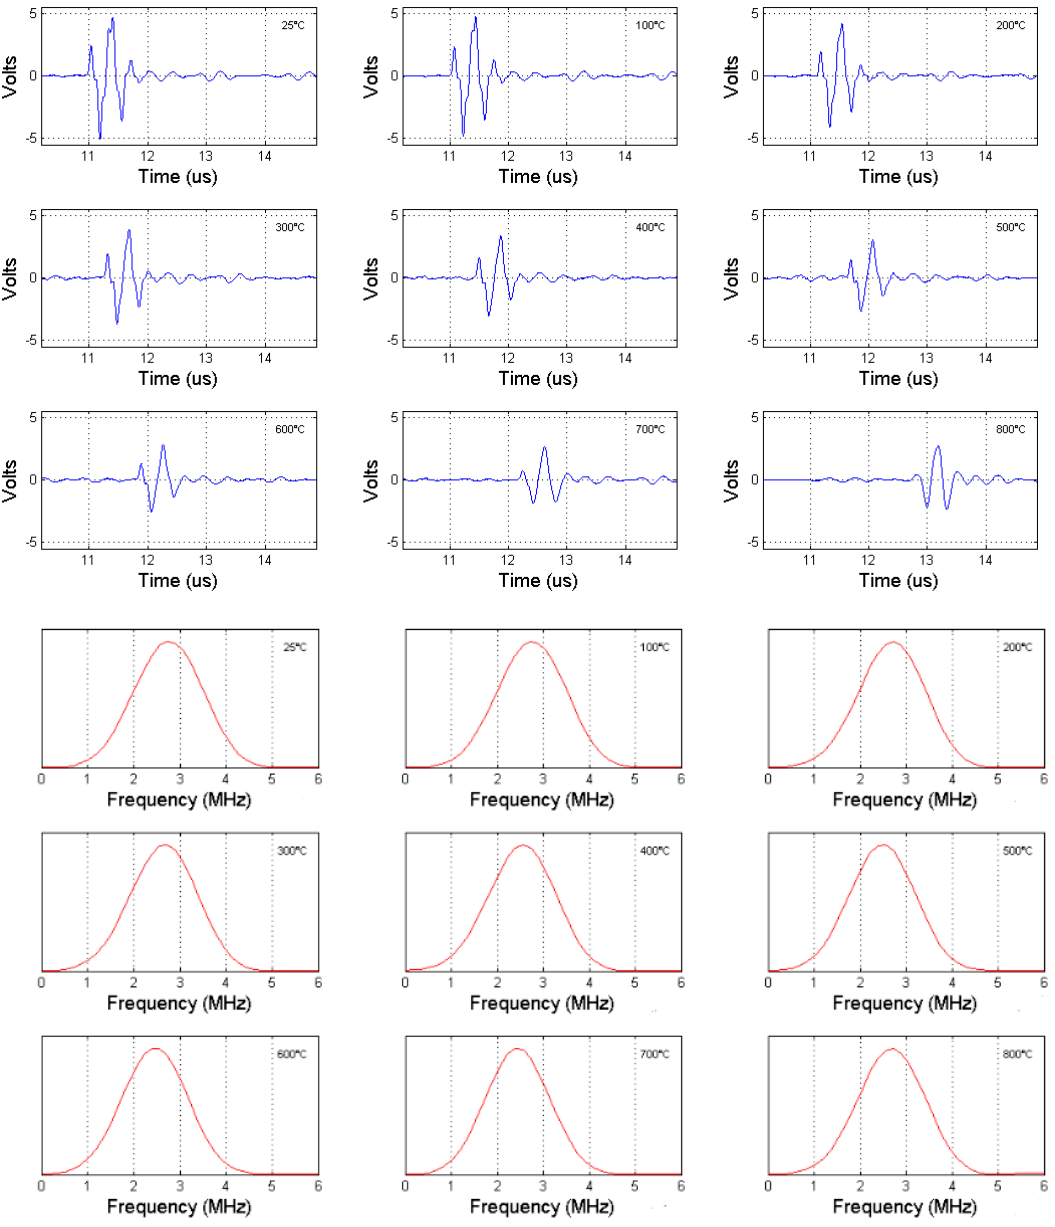
Figure 9. Ultrasound performance at elevated temperatures of LiNbO 3 and porous zirconia transducers brazed with AgCu brazing material. Corresponding time and frequency plots are included from room temperature to 800 °C.